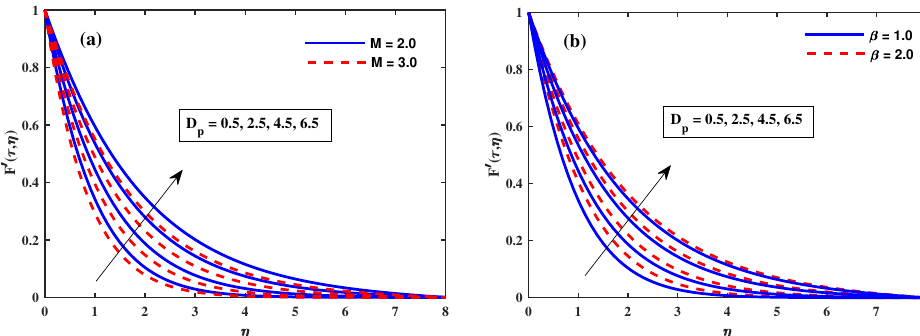
Figure 2. Curve of F (cid:48) ( τ , η ) against D p (nanoparticle radius), M ( a ), and β ( b ).